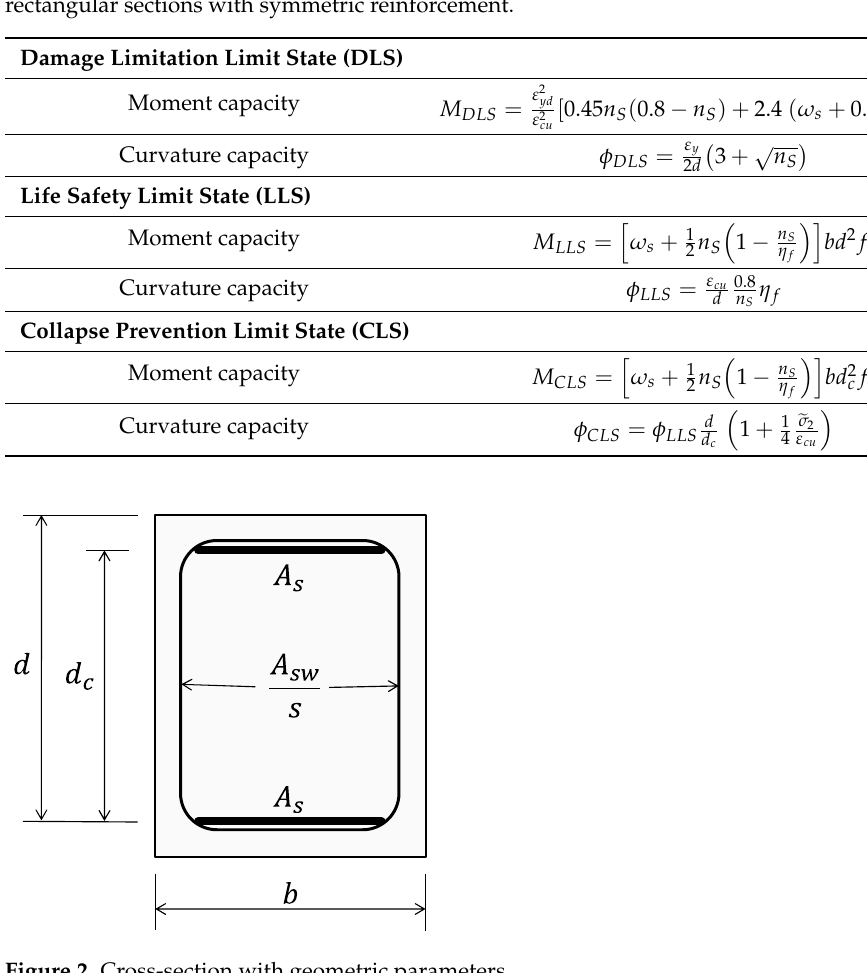
Figure 1. Cross-section with geometric parameters. Figure 2. Cross-section with geometric Table 1. Flexural failure: equations for resisting moment and curvature at three LSs for the case of rectangular sections with symmetric reinforcement.